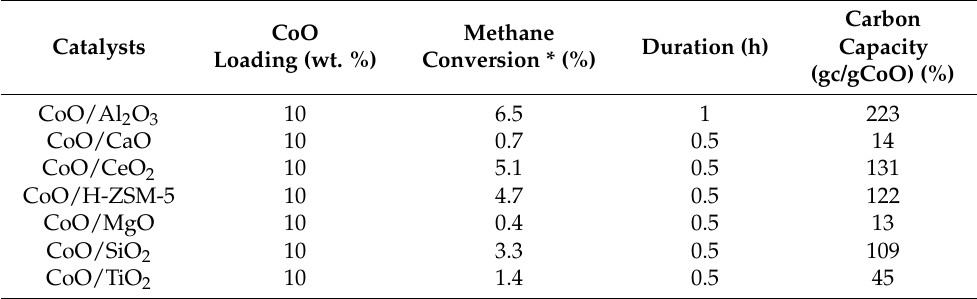
Table 2. The catalytic activity of cobalt catalysts on different supports at 700 ◦ C and 1 atm [38].